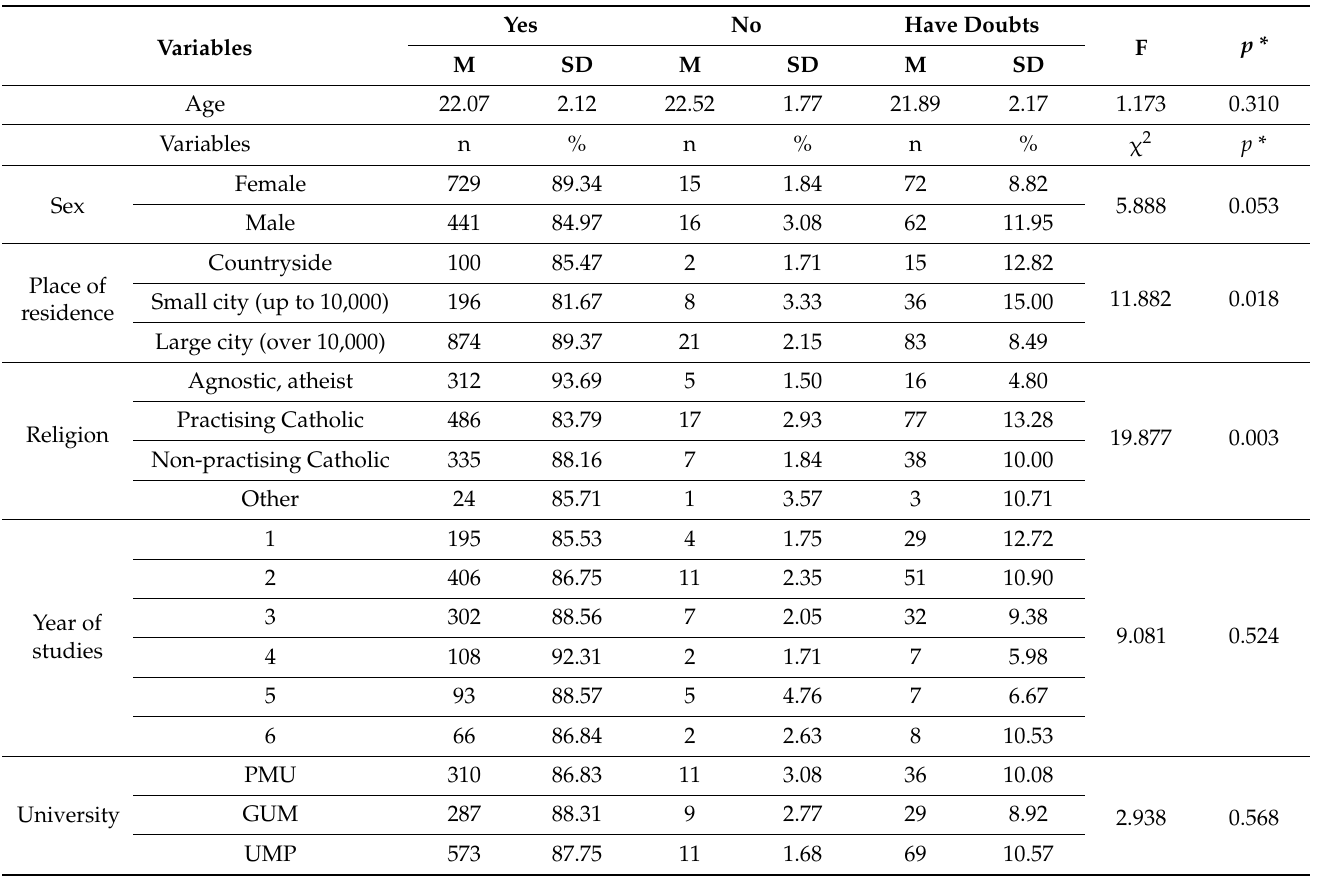
Table 4. The effect of selected variables on the answer to the question “Would you consider donating your organs after